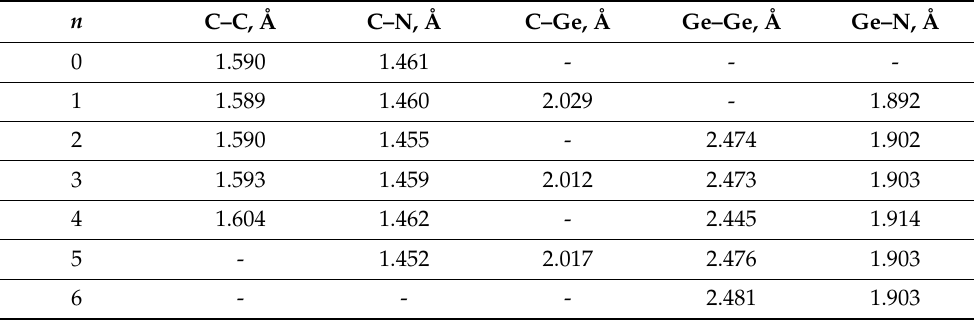
Table 3. The average bond lengths of the most thermodynamically stable compounds Ge n CL-20 obtained at the DFT/B3LYP/6-311G(d,p) level of theory. A dash “-” means that this bond is not found in the compound.